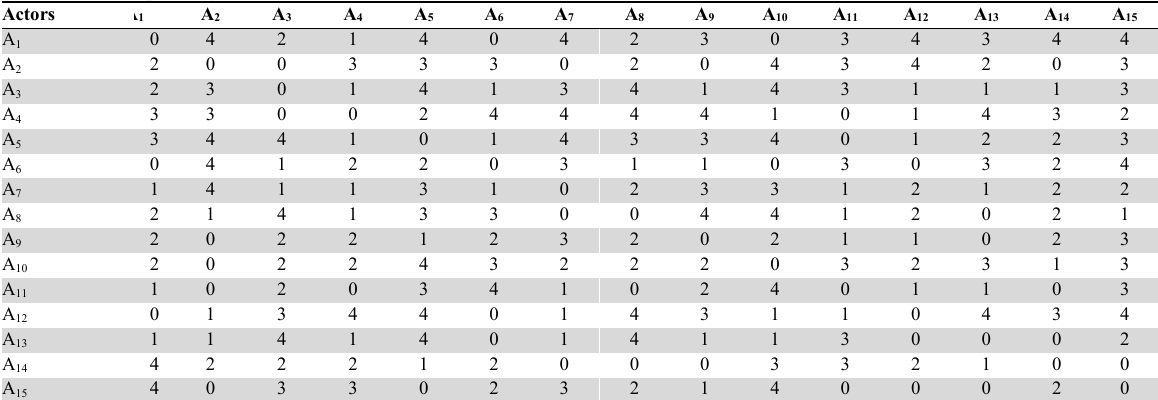
Matrix A t shows the degrees of Technological Risk (TR) between two actors at tactical/operational levels in the port system Actors